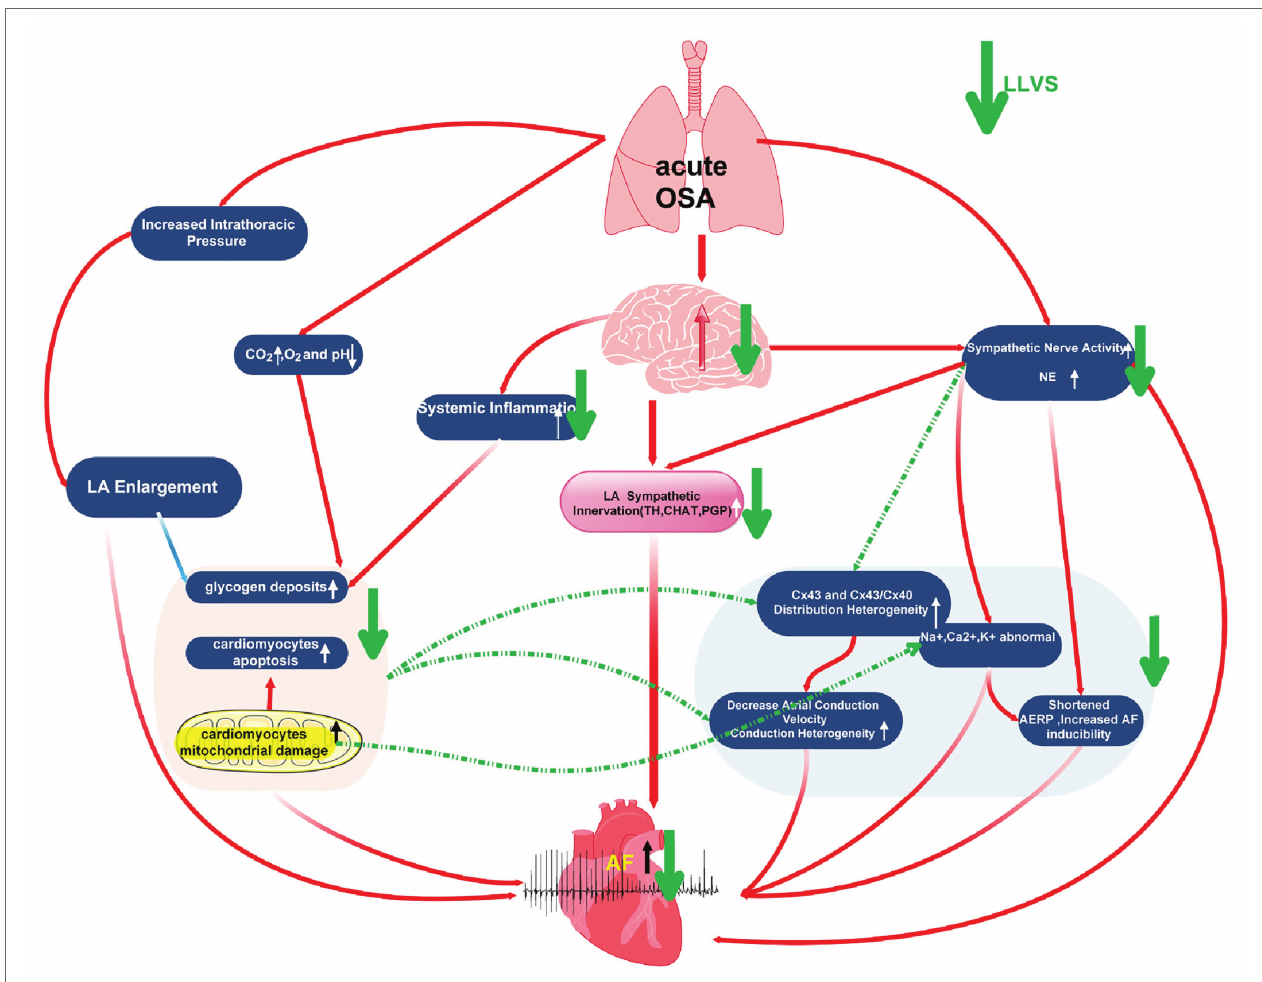
FIGURE 8 | Graphic illustration of possible mechanism about acute OSA induced-atrial